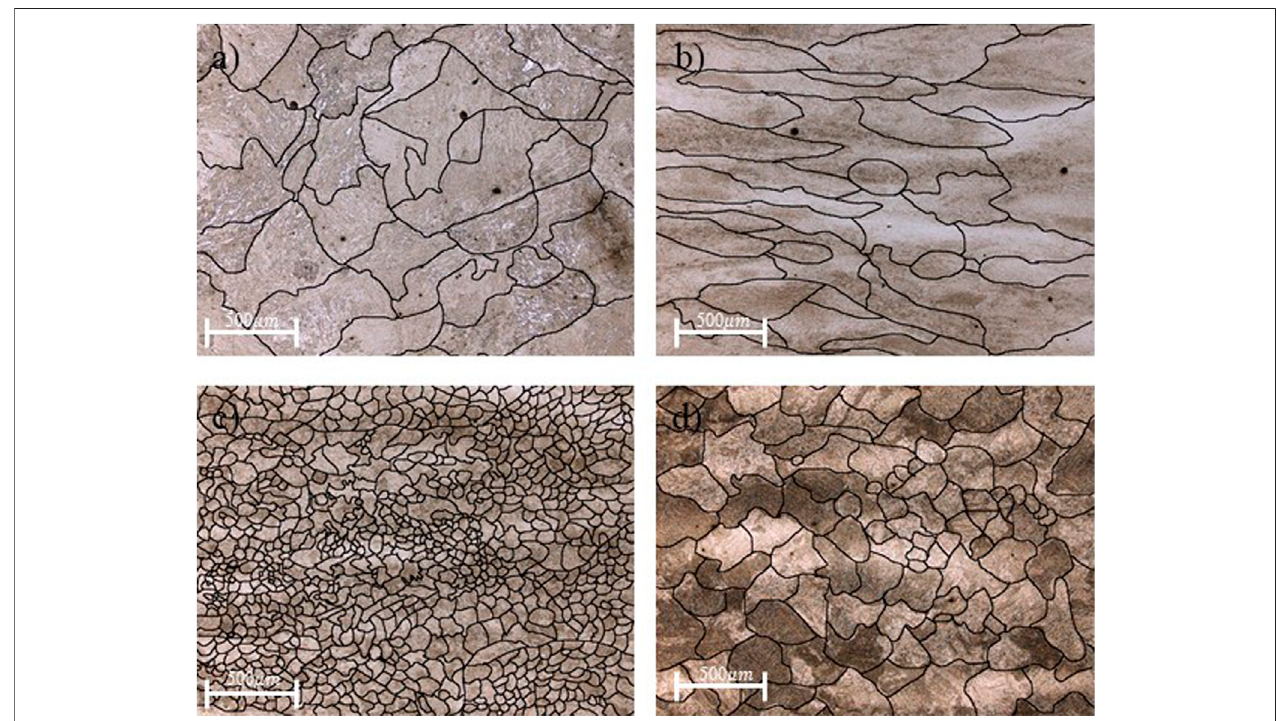
FIGURE 11 | Optical micrography of (A) as-received material, (B) deformed at 950 ° C 0.01 s − 1 , (C) deformed at 1,050 ° C 0.01 s − 1 , and (D) deformed at 1,250 ° C 0.01 s − 1 , etched with Nital 3%.